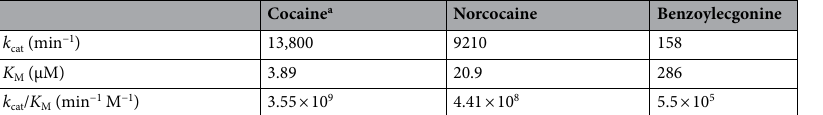
Table 1. Kinetic parameters of CocH5-Fc(M6) against (-)-cocaine, norcocaine, and benzoylecgonine at 37 °C. a Kinetic parameters for cocaine came from our previous report 9